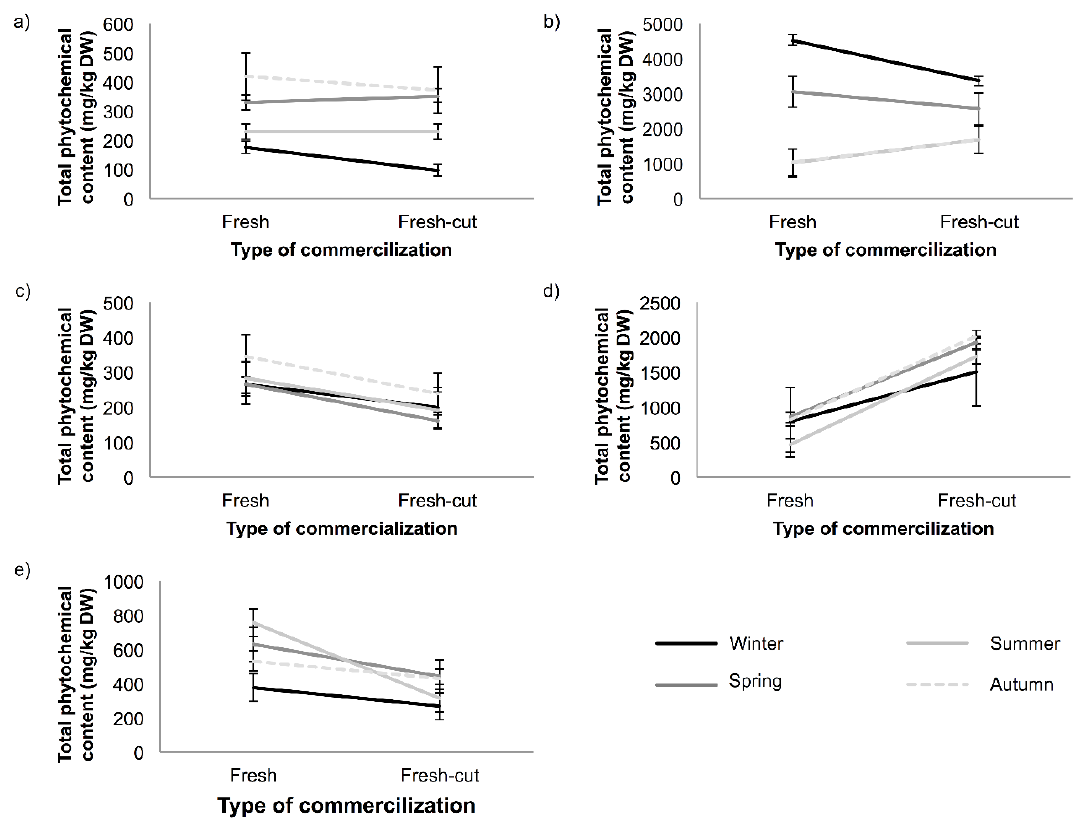
Figure 1. Total phytochemical content (mg/kg, dry weight (DW)) during the different seasons of the year in fresh and fresh-cut: ( a ) tomato; ( b ) broccoli; ( c ) grape; ( d ) eggplant; and ( e )